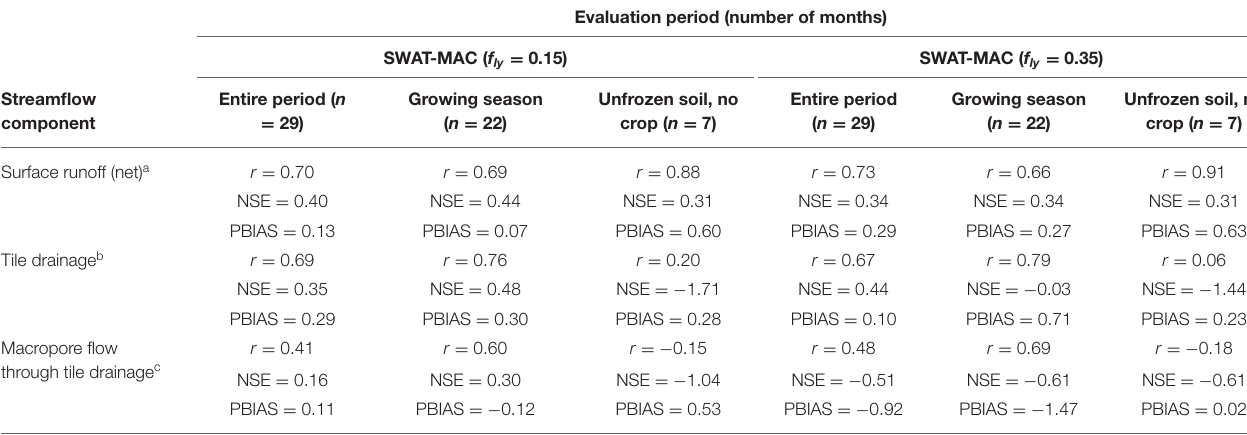
TABLE 5 | Goodness-of-fit statistics for surface runoff, tile drainage and macropore flow through tile drainage from the Ewing subwatershed of the Pike River watershed, southern Quebec, Canada. Evaluation period (number of months)